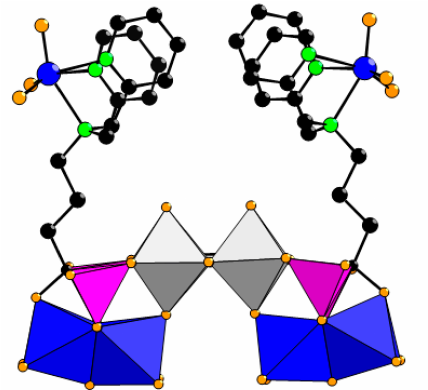
Figure 5. Mixed polyhedral/ball-and-stick representation of the mixed-valent POM [(Mo V 2 O 4 )(Mo VI 2 O 6 ) 2 {O 3 PC(O)(C 3 H 6 N(CH 2 C 5 H 4 N) 2 (Mo VI O 3 ))PO 3 } 2 ] 8 − in NH 4 Mo 6 (AlePy 2 Mo) 2 ; blue octahedra: Mo VI O 6 , grey octahedra: Mo V O 6, blue spheres: Mo VI , pink tetrahedra: P, orange spheres: O, black spheres: C, green spheres: N; hydrogen atoms have been omitted for